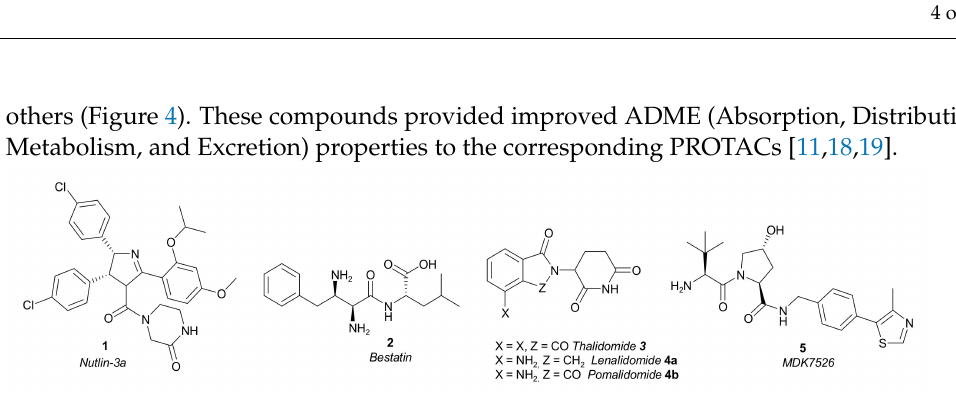
Figure 4. Examples of small molecules used as E3-ligase recruiters: Nutlin-3a 1 , Bestatin 2 , Thalidomide 3 , Lenalidomide 4a , Pomalidomide 4b , and MDK7525 5 .